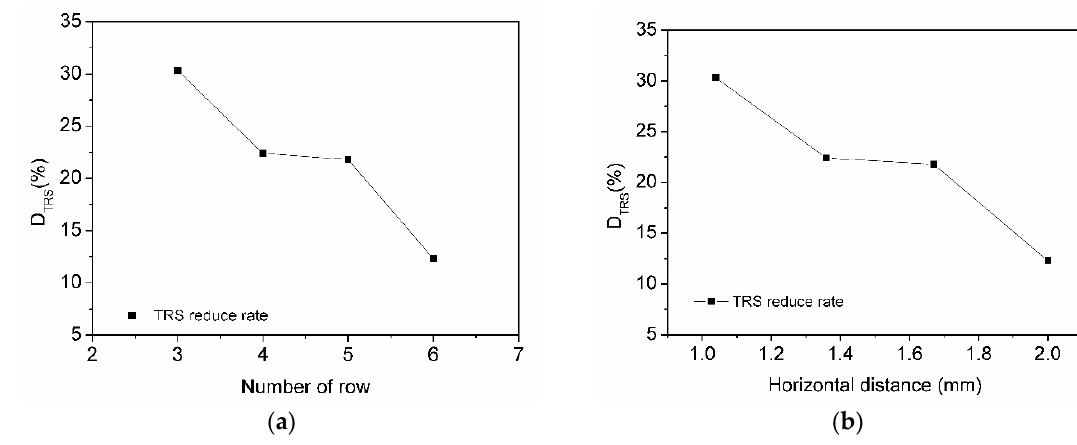
Figure 12. Order distribution versus reduction rate of TRS. ( a ) Effect of row number; ( b ) effect of horizontal distance.